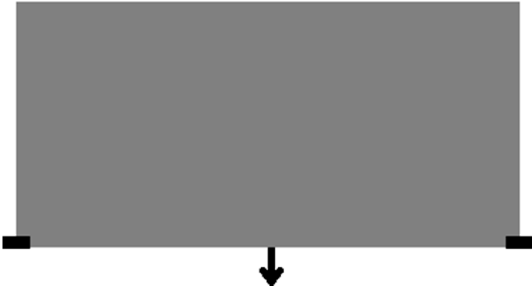
Figure 9. Schematic of the Michell structure problem definition.